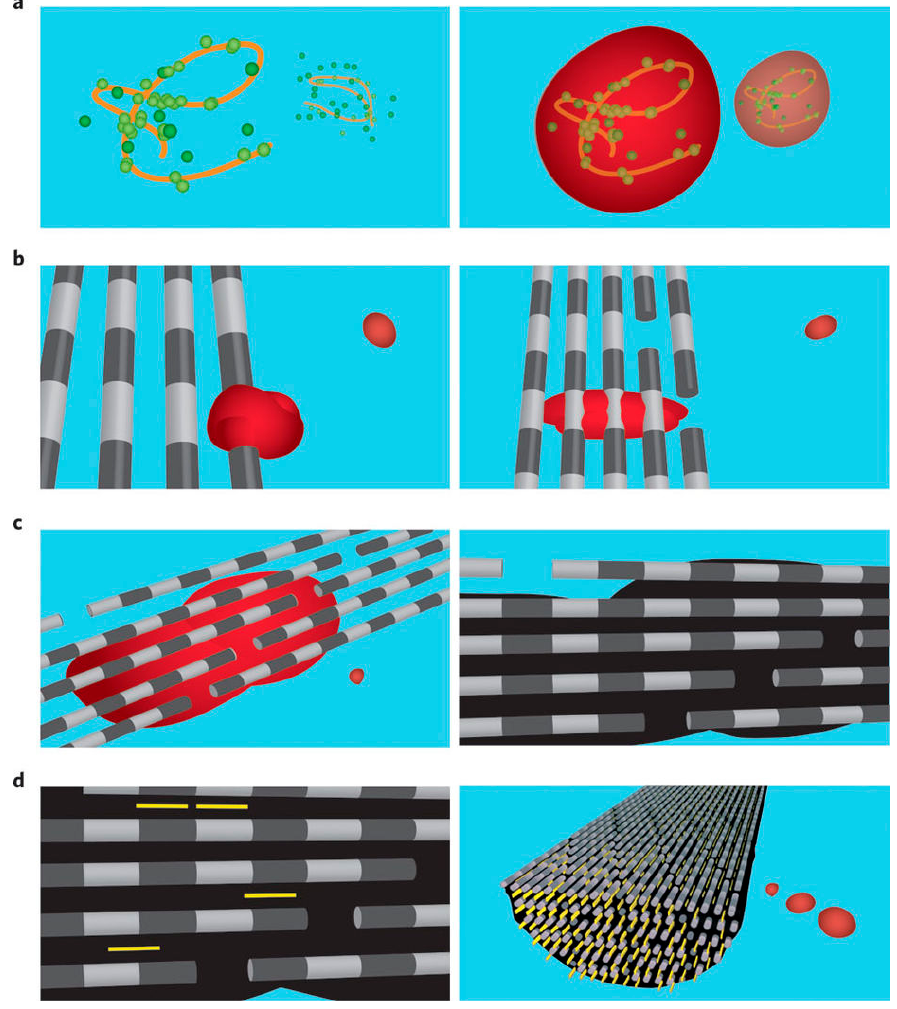
Figure 6. ( a ), Calcium phosphate clusters(green) form complexes with the polymer (orange line), forming stable mineral droplets. ( b ), Mineral droplets bind to a distinct region on the collagen fibres and enter the fibril. ( c ), Once inside the collagen, the mineral in a liquid state diffuses through the interior of the fibril and solidifies into a disordered(amorphous) phase (black). ( d ), Finally, directed by the collagen, the amorphous mineral transforms into oriented apatite crystals(yellow).Reproduced with permission from Springer Nature in Reference [139].